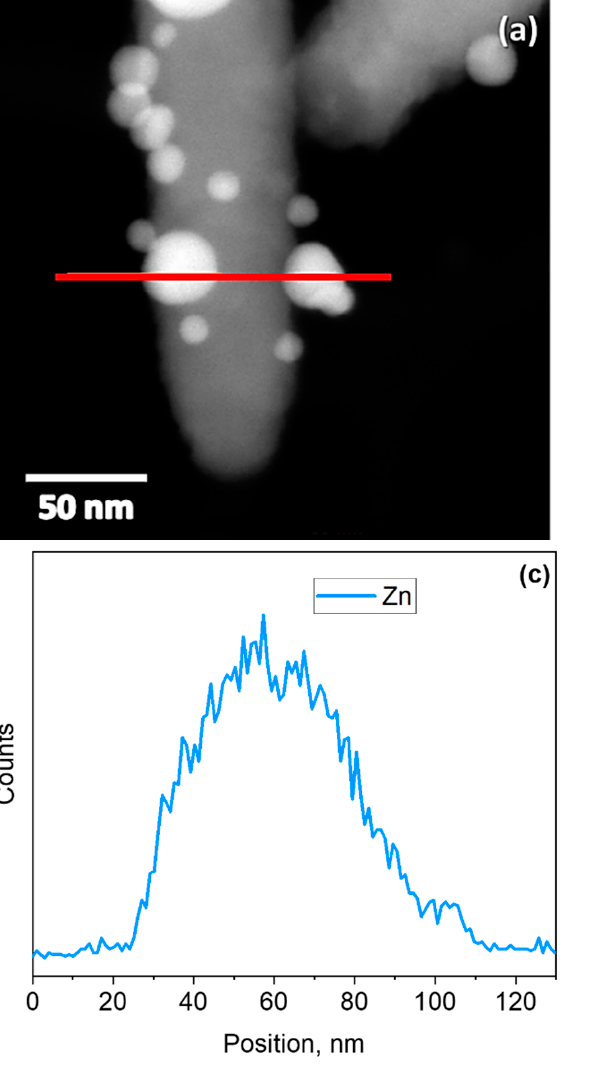
Figure 2. TEM image of an Au-modified ZnO rod. ( a ) Low-magnification STEM image, ( b ) high-resolution TEM image, and EDS line-scan profiles corresponding to the ( c ) ZnO rod and ( d ) Au nanoparticles recorded along the red line in ( a ).